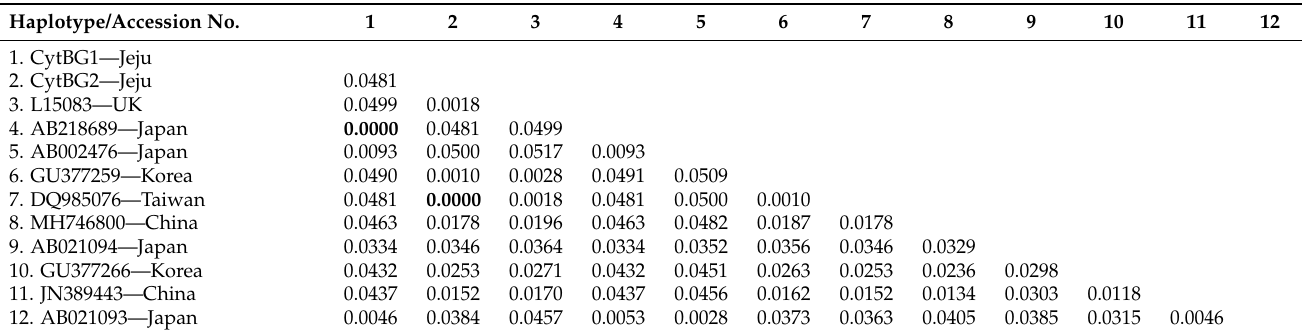
Table 2. Pairwise genetic distance between the haplotypes of C. nippon .